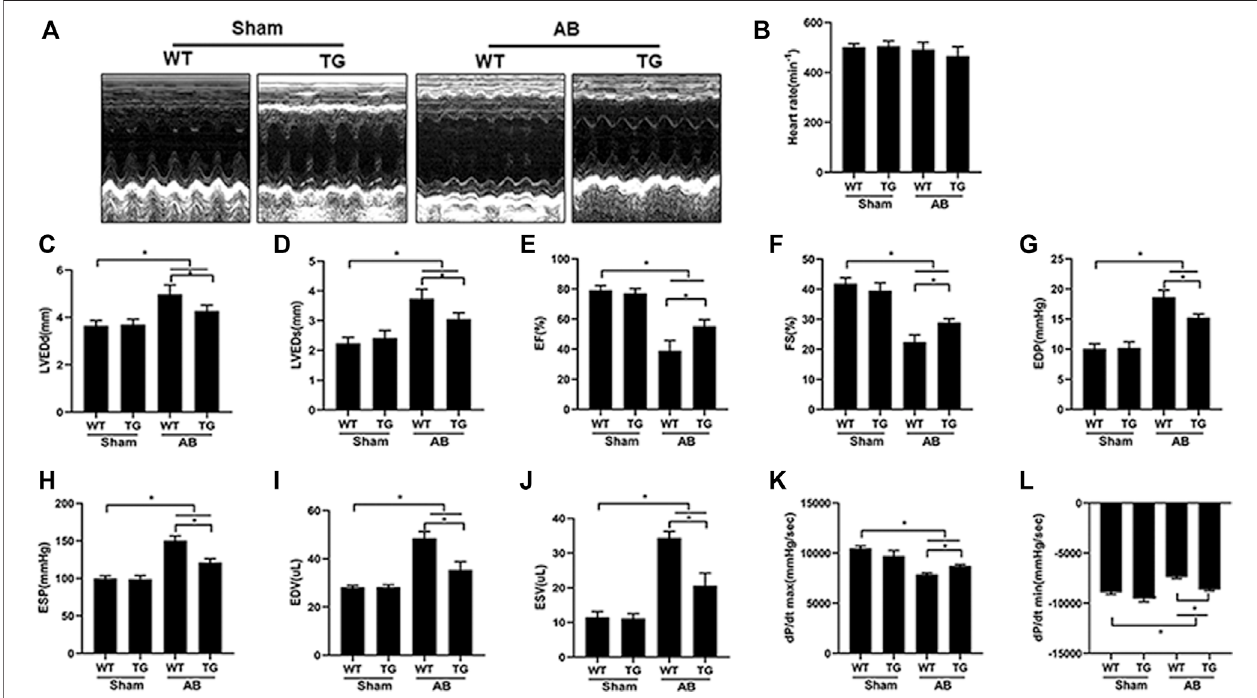
FIGURE 2 | Cardiomyocyte-speci fi c overexpression of Sesn2 attenuated pressure overload-induced cardiac dysfunction. (A) Representative echocardiographic images in each group ( n (cid:1) 6). Echocardiography and pressure-volume loop were performed to evaluate mouse cardiac function at 8 weeks after AB surgery ( n (cid:1) 6). (B) heartrate(HR), (C) leftventricularenddiastolicdiameter(LVEDd), (D) leftventricularendsystolicdiameter(LVEDs), (E) leftventricularejectionfraction(EF), (F) LVfraction shortening (FS), (G) end diastolic pressure (EDP), (H) end systolic pressure (ESP), (I) end diastolic volume (EDV), (J) end systolic volume (ESV), (K) left ventricular maximal rate of pressure rise (dp/dt max), (L) left ventricular maximal rate of pressure decay (dp/dt min). Data were presented as the mean ± SD. * p < 0.05 vs indicated group. One-way analysis of variance (ANOVA) followed by Tukey post hoc tests were used for signi fi cance